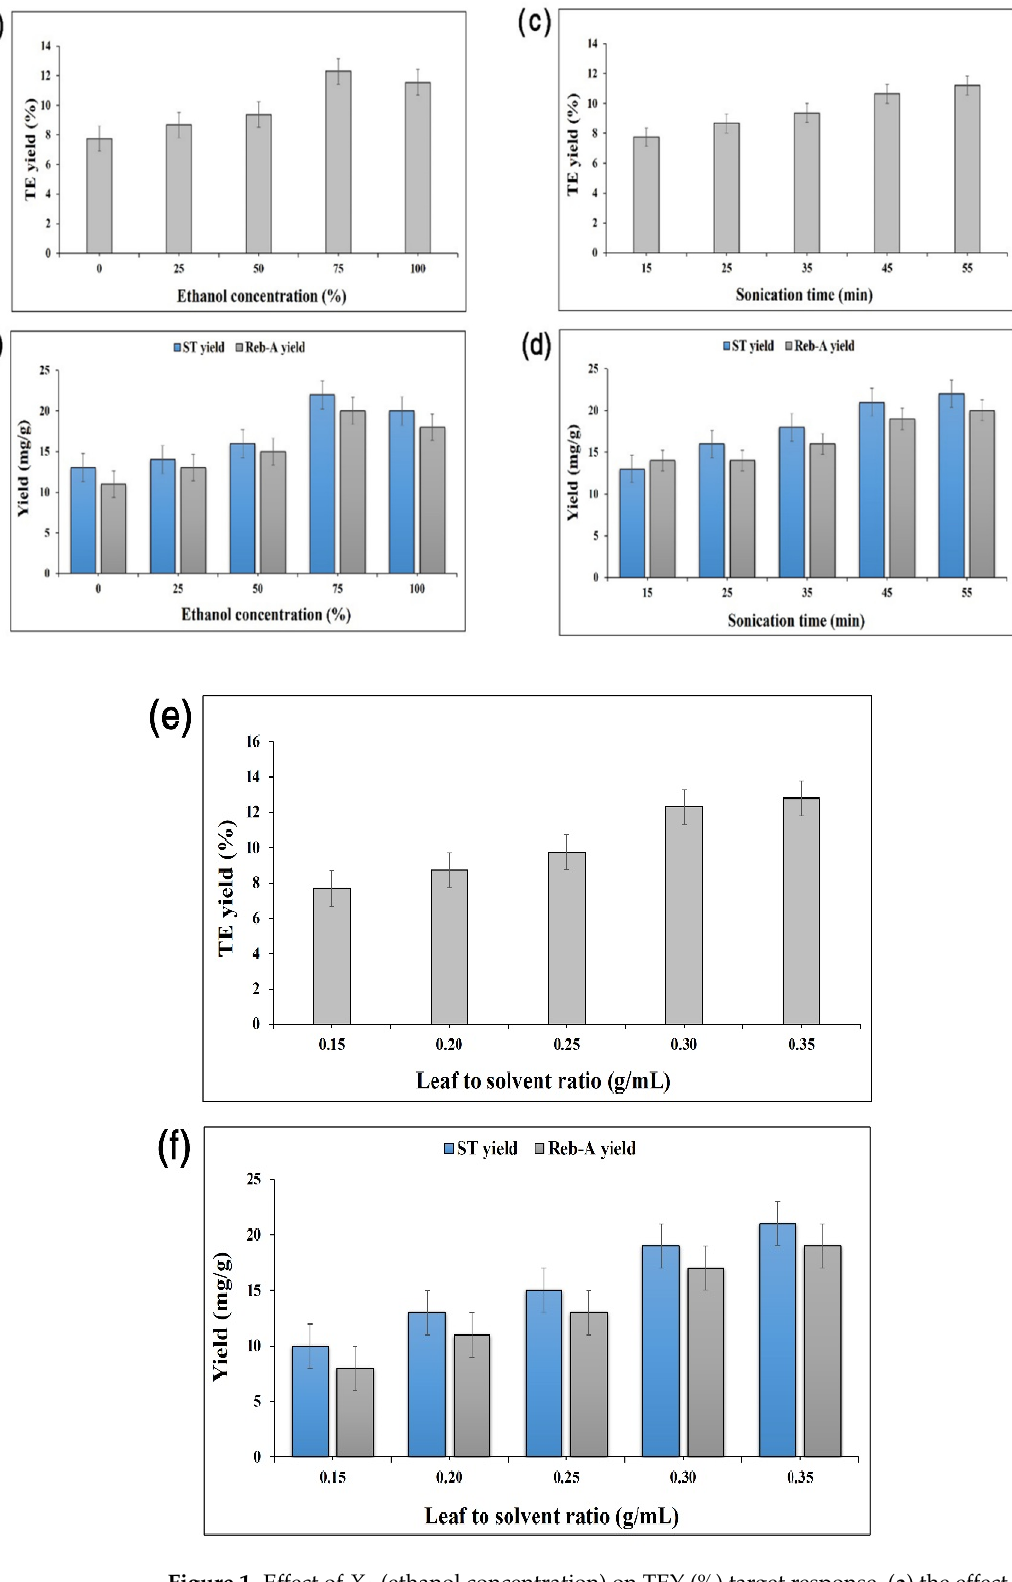
Figure 1. Effect of X 1 (ethanol concentration) on TEY (%) target response, ( a ) the effect of X 1 (ethanol concentration) on ST and Reb-A yields (mg/g), ( b ) ST yield: sonication time effect on TEY (%) target response, ( c ) sonication time effect on ST and Reb-A yields (mg/g), ( d ) Leaf-to-solvent ratio effect on the TEY (%) response, ( e ) Leaf-to-solvent ratio effect on ST and Reb-A yields (mg/g) responses ( f ).